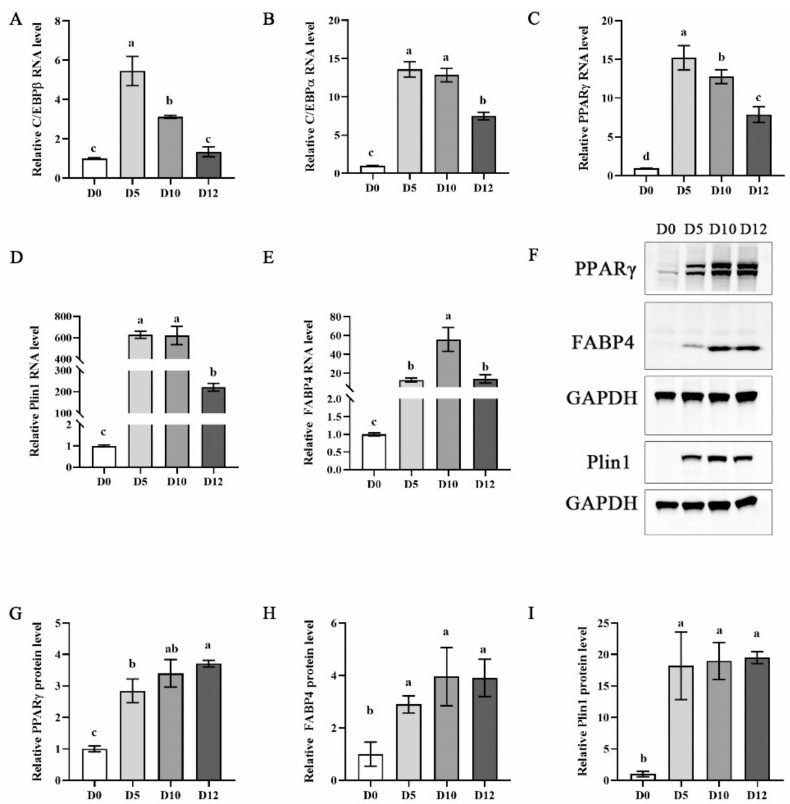
Figure 4. Confirmation the terminal adipogenesis of ADSC. ( A – E ) qPCR analysis the expression of adipogenic differentiation marker genes C/EBP β , C/EBP α , PPAR γ , FABP4 and Plin1 . ( F ) Western blot analysis the expression of adipogenic differentiation marker proteins PPAR γ , Plin1 and FABP4 . ( G – I ) Quantitative adipogenic differentiation marker proteins PPAR γ , Plin1 and FABP4 . Statistical testing: a–d, different letters in the same columns indicate significant differences. p < 0.05, and error bars indicate